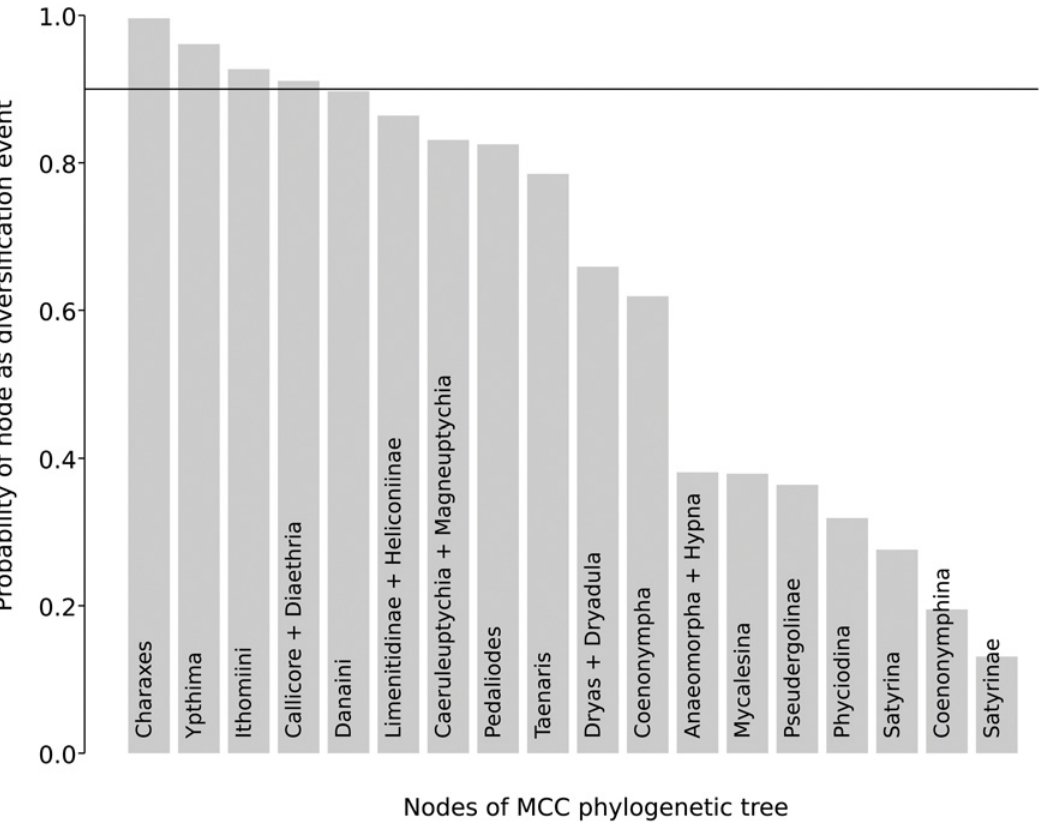
Fig 3. Results of MultiMEDUSA analysis showing the probability of specific nodes being characterized by significant shifts in diversification rate.